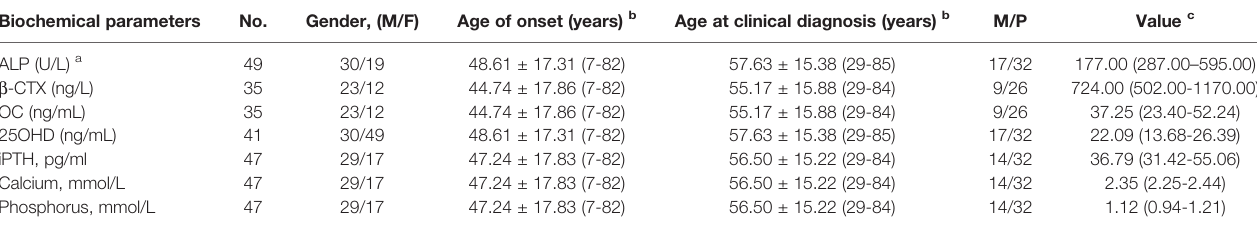
TABLE 2 | Biochemical pro fi le of PDB patients in China. Biochemical parameters